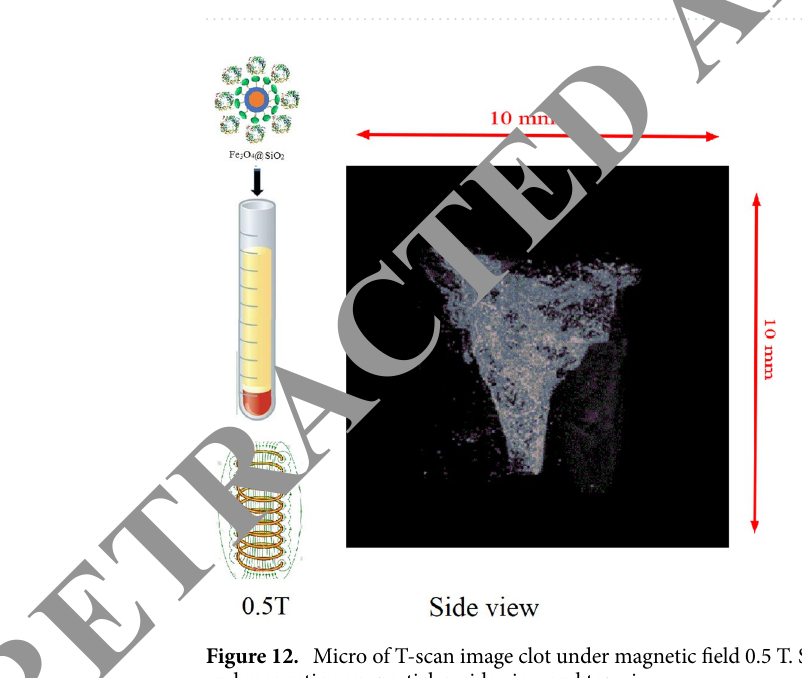
Figure 12. Micro of T-scan image clot under magnetic field 0.5 T. Schematic of applying magnetic field on clot and magnetic nanoparticles, side view and top